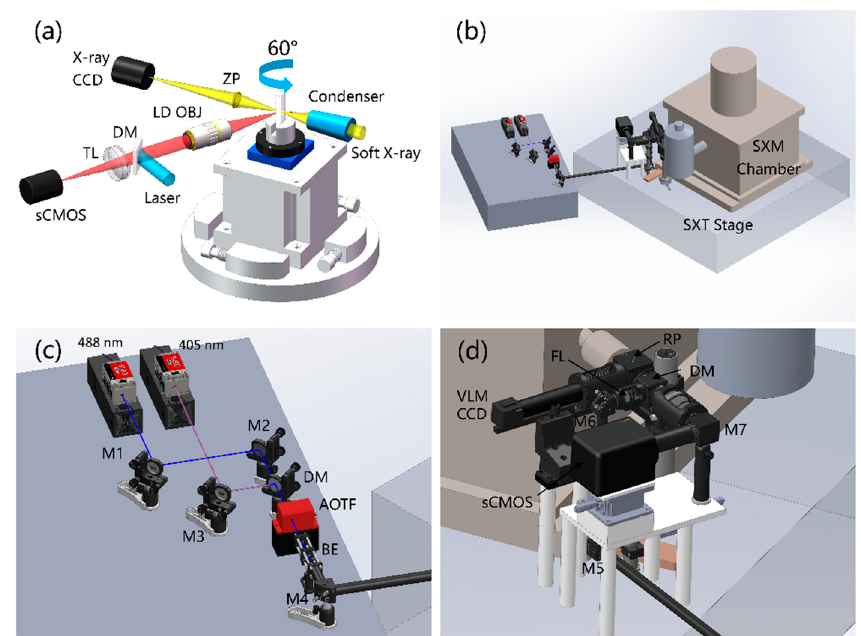
Figure 1. The layout of soft X-ray microscopy and on-line FM. ( a ) Schematic diagram of on-line FM at BL07W@NSRL station; ( b ) implementation diagram of on-line FM; ( c ) zoomed laser excitation unit and ( d ) zoomed fluorescence collection unit in panel ( b ) .